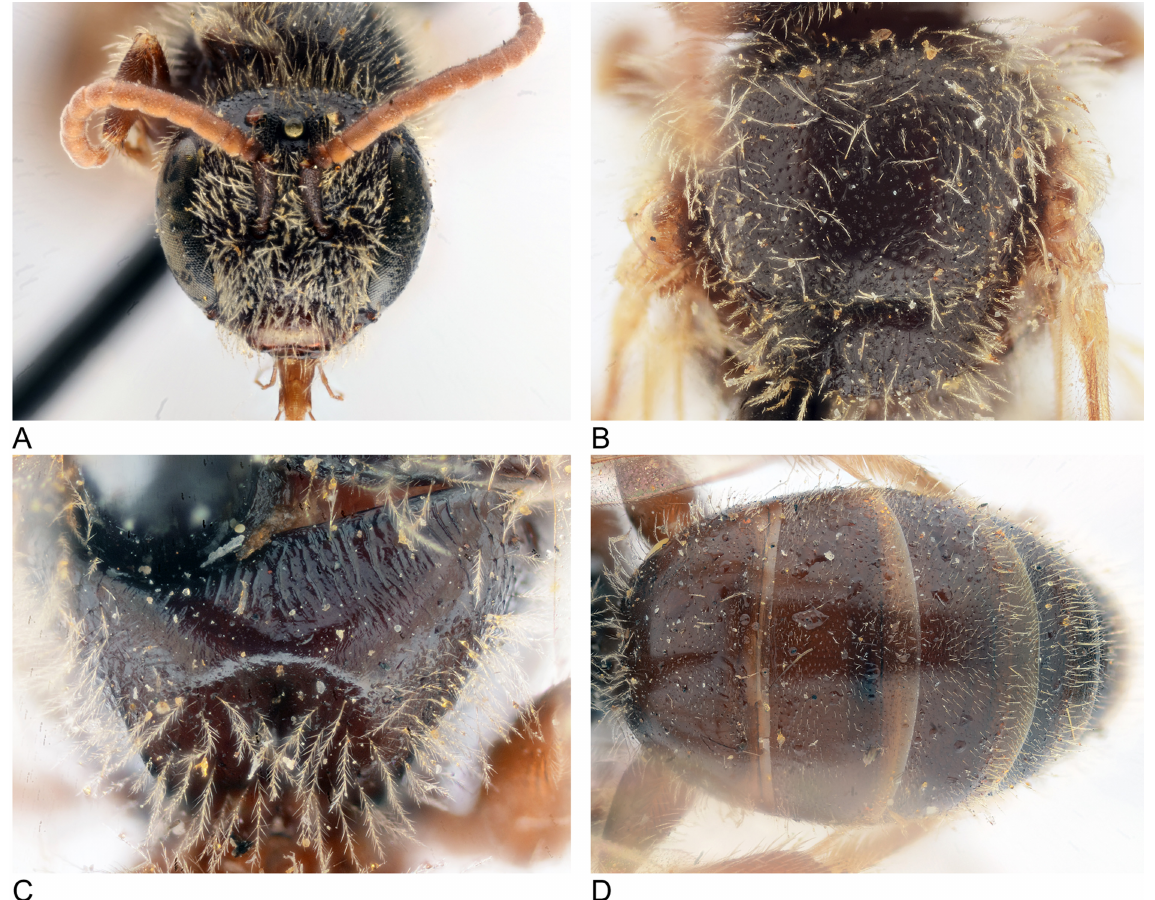
Fig. 15. Lasioglossum medinai (Vachal, 1895), holotype, ♂. A . Head. B . Scutum. C . Propodeum. D .